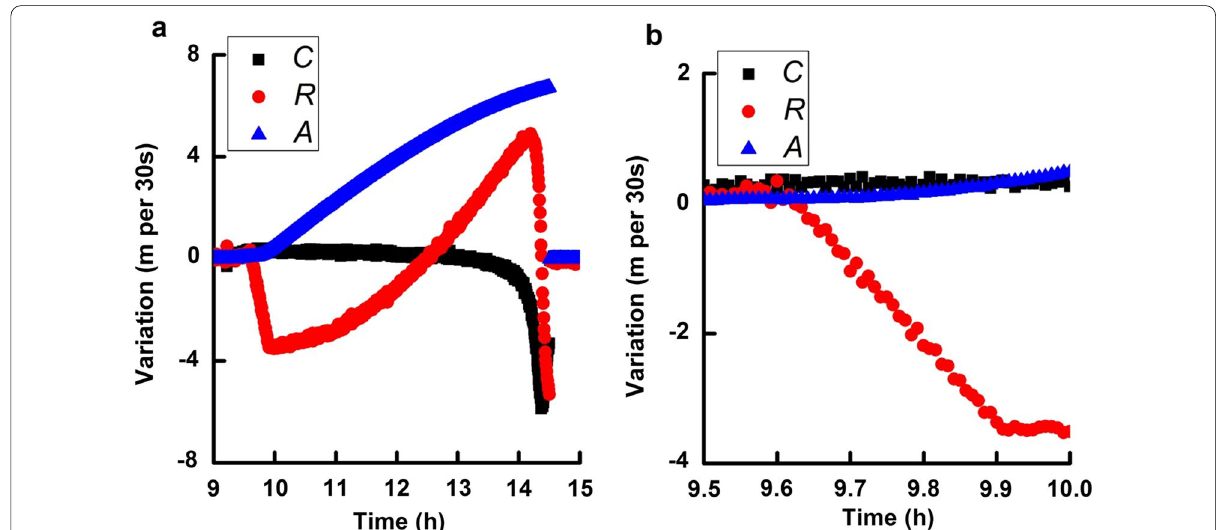
Fig. 2 Time series of the estimated velocity variations a and the details of the velocity b for BDS C01 during the maneuver period. The black, red, and green colors represent the Cross, Radial, and Along components, respectively